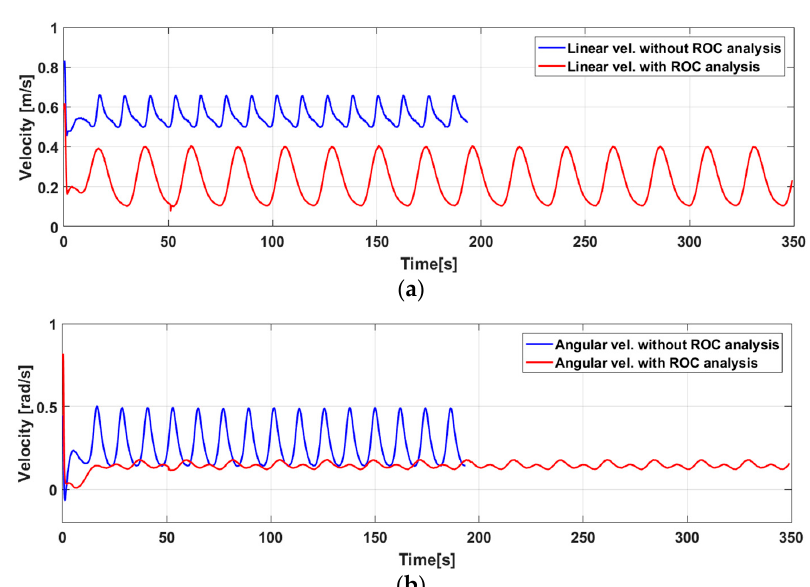
Figure 11. Control actions of the platform for the execution of follow-up without ROC analysis consideration and with consideration of ROC analysis. ( a ) robotic arm, ( b ) mobile robot.